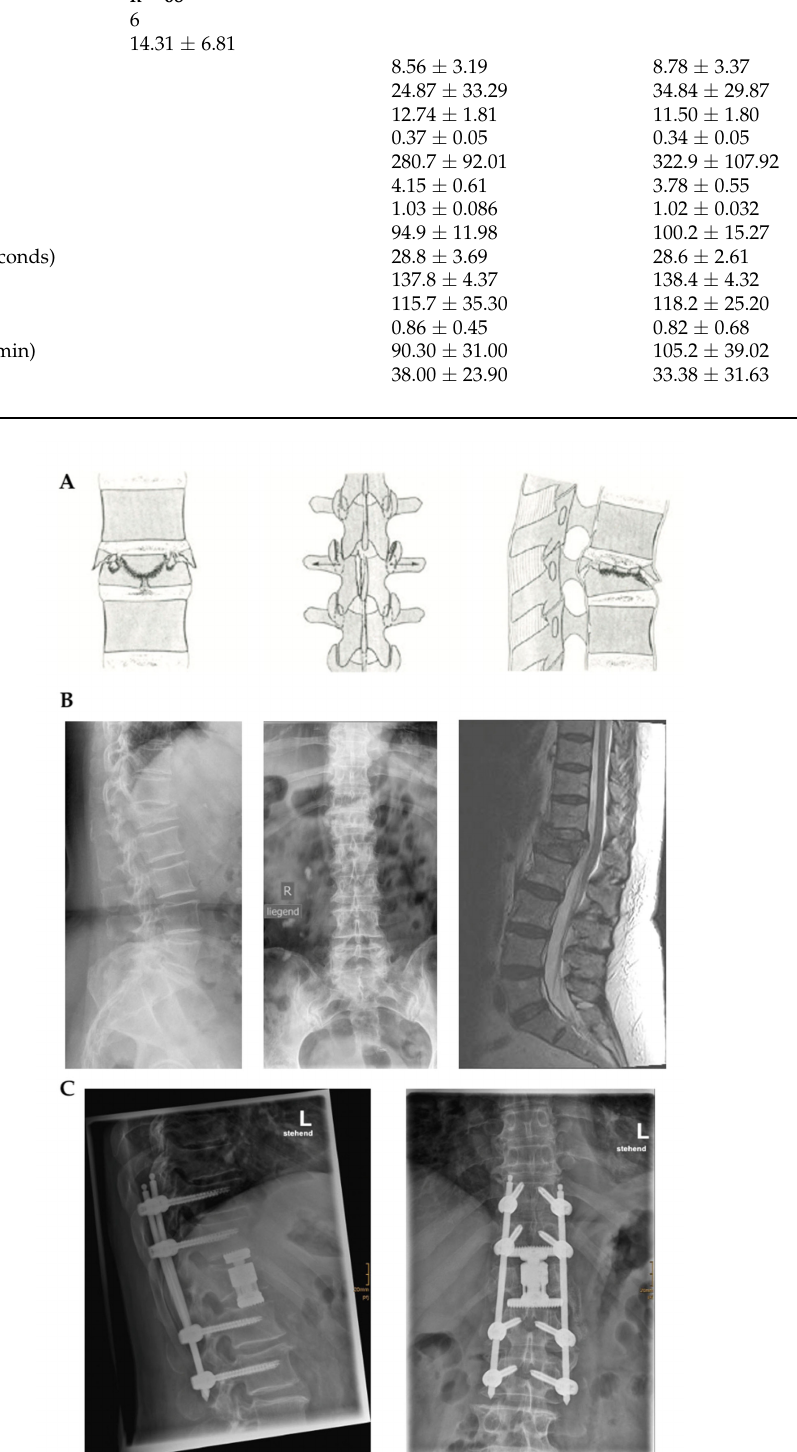
Figure 1. Illustration of one case of the cohort with an A3 cranial burst split fracture ( A , B ). Percuta- neous stabilization at level Th11-L3, nucleotomy at Th12/L1 and L1/L2, corporectomy, and vertebral body replacement at L1 ( C ) were used to manage the